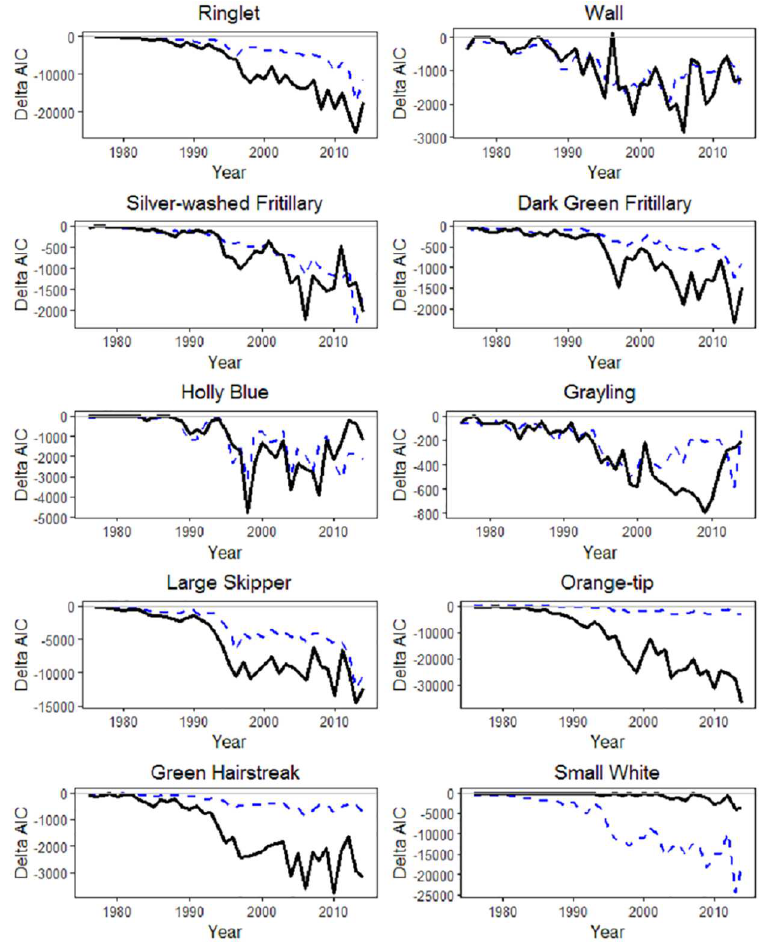
Fig 2. AIC comparison using varying covariatesfor detection probability. The solid black line compares havingthe seasonalcovariate and list length as two covariates,rather than with just list length. The dashed blue line compareshavingthe seasonalcovariateand list length as two covariates, rather than with just the seasonalcovariate.